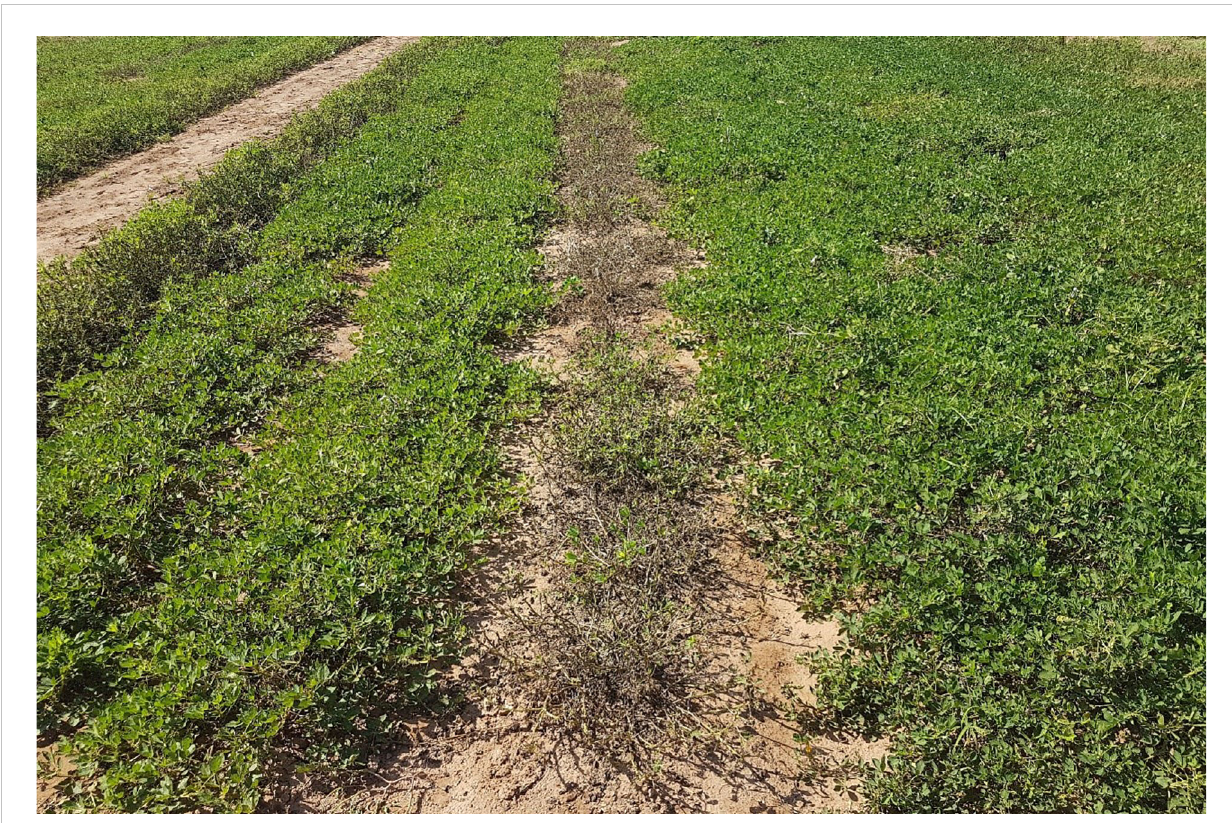
FIGURE 5 Field trial of BC 3 F 5 plants descending from ‘ IAC OL 4 ’ × ( A. magna K30097 × A. stenosperma V15076) 4x . Disease pressure was high and no fungicide sprays were applied. Field at the middle of the season. Mid row is the susceptible control ‘ IAC OL 3 ’ , highly affected by LLS, and left and right rows are BC 3 F 5 plants with chromosome segments conferring disease